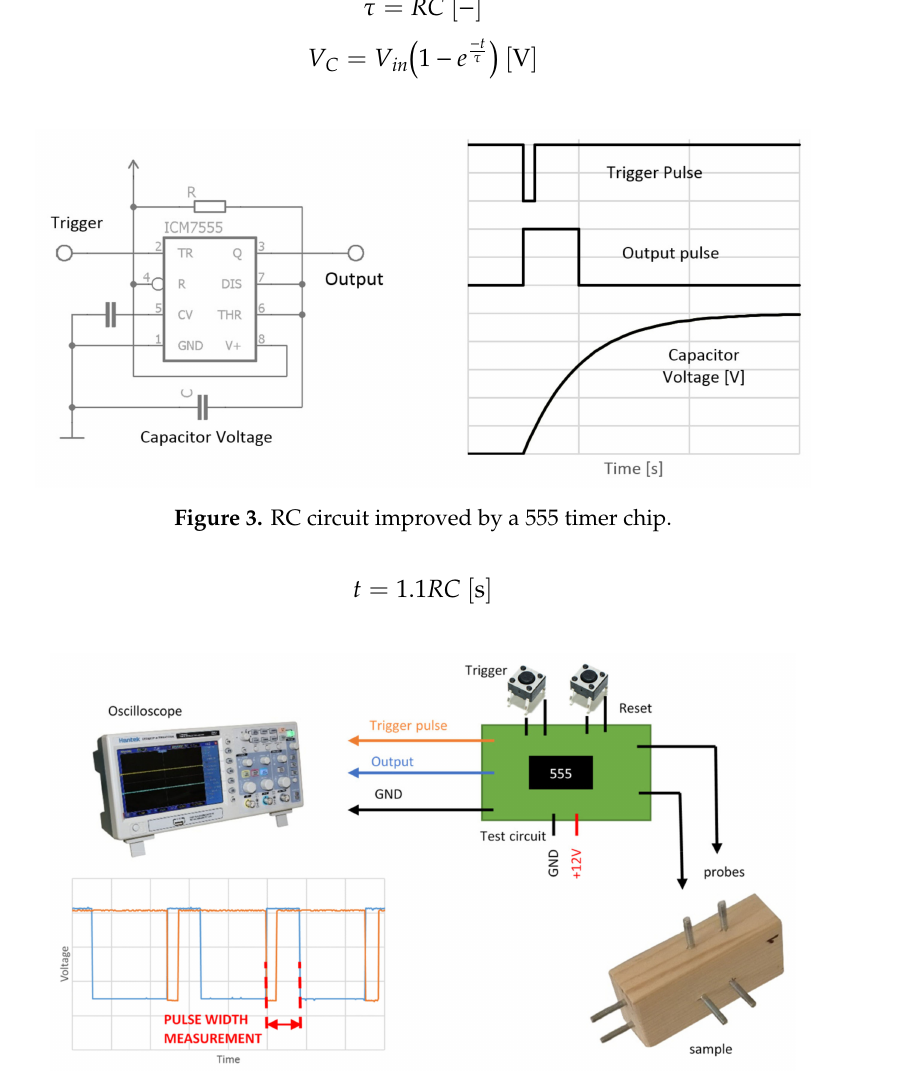
Figure 4. The complete principle of the RC circuit for the moisture content